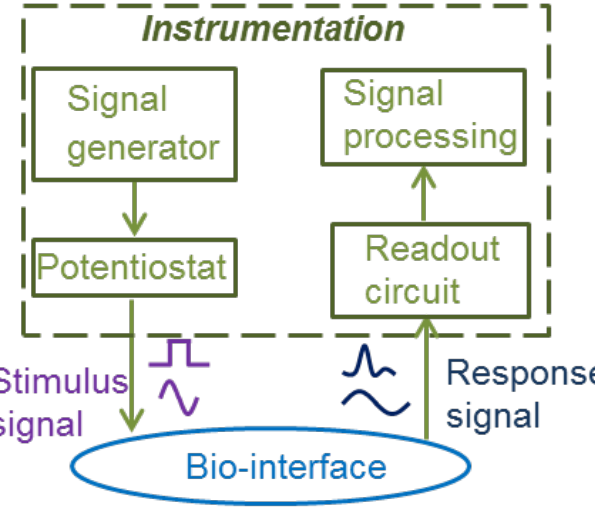
Figure 4. The structure of the instrumentation for electrochemical biosensors.